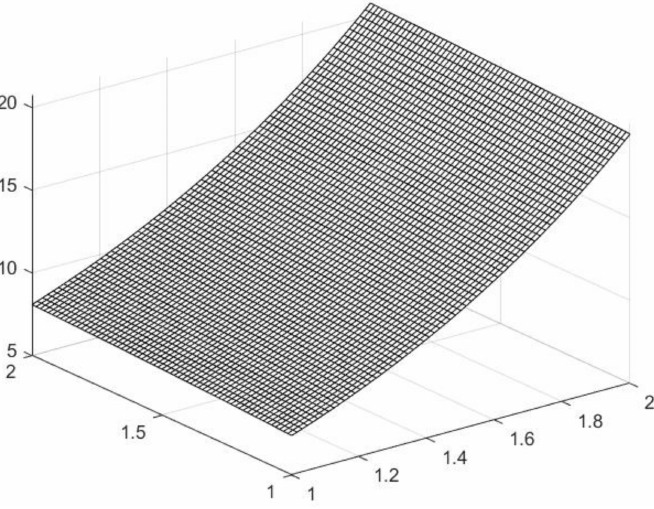
Figure 6. Numerical solutions of difference equations ( h = 1 / 64, τ = 1 / 128 ) . Figure 7 shows the numerical solutions obtained by PDETOOL of